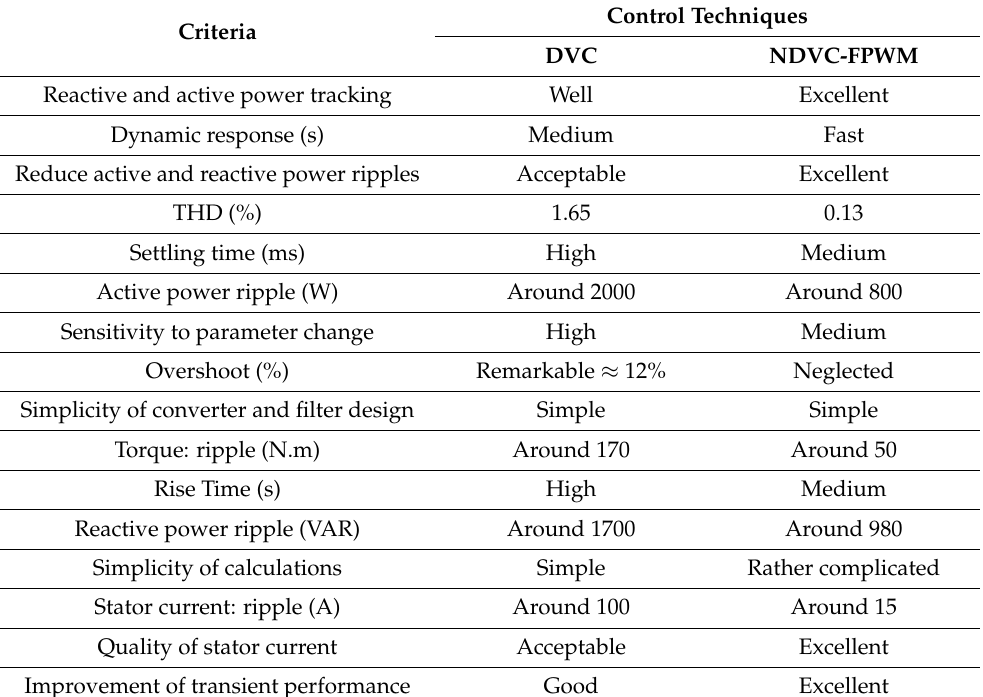
Table 2. Comparative results were obtained from the NDVC-FPWM with the DVC control. Criteria